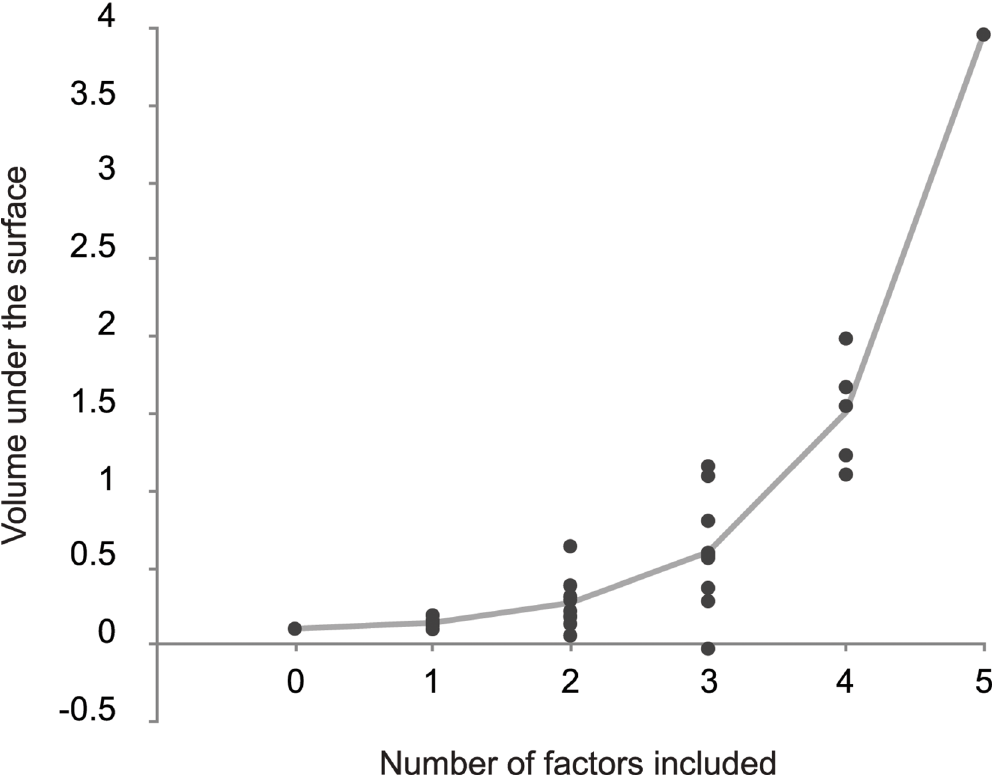
Fig 14. Volume under the surface for all 32 tasks generated by the 5 binary factors discussed in this paper. Each dot represents the volume under the surface of linear regression coefficients for one task, and is plotted as a function of the number of ‘ beneficial ’ factors that are included in each task ’ s design. The gray line represents the average increase in the strength of the relationship between model-based control and